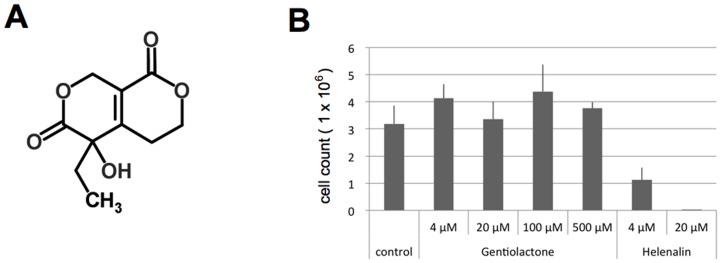
Gentiolactone and cytotoxicity of gentiolactone.A, Structure of gentiolactone. The molecular formula of gentiolactone is C10H12O5 and its monoisotopic mass is 212.068. B, RAW264.7 cells were seeded in 6-well culture plates (1×106 cells/well) and cultured with gentiolactone or helenalin for 24 hours. At the end of this period, the number of living cells in each well was counted.